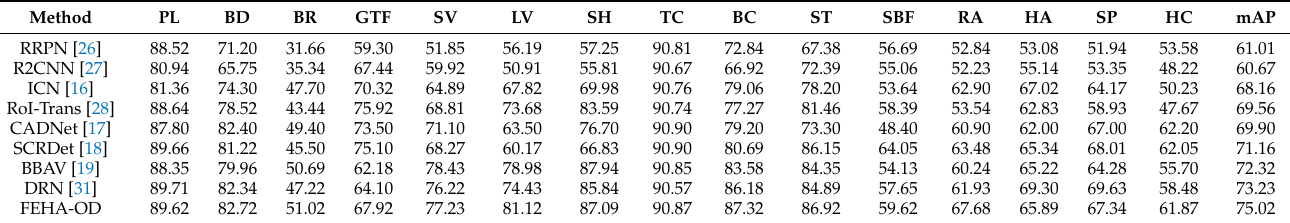
Table 4. Experimental results comparing different